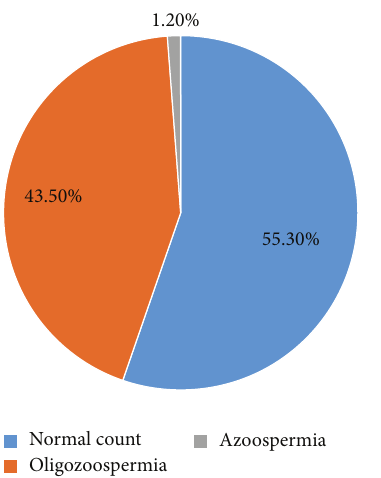
Figure 1: Semen density pattern of the study population.